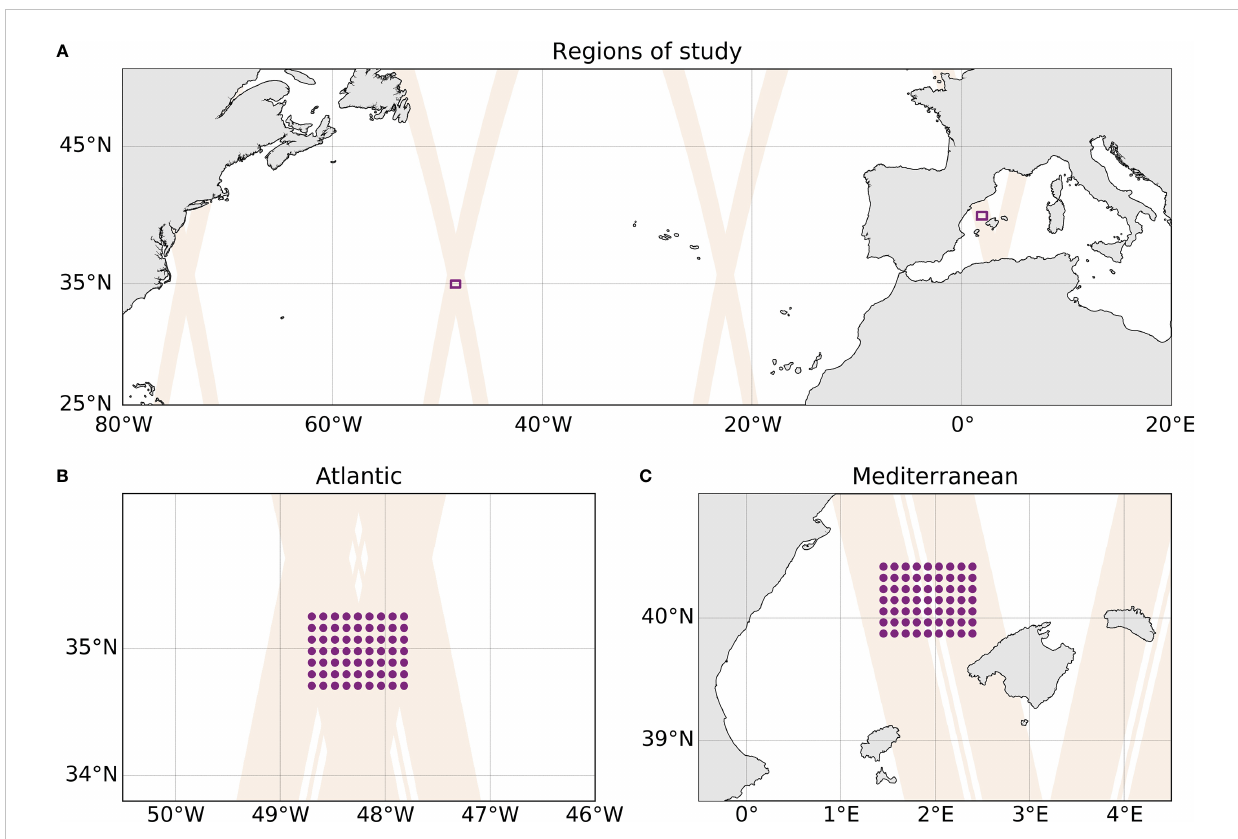
FIGURE 1 (A) Map with the regions of study (magenta boxes) and the swaths of SWOT during the fast-sampling phase (orange bands). (B, C) show a zoom around the regions of study. (B) SWOT crossover in the subpolar northwest Atlantic (orange bands) with the position of the reference con fi guration CTD casts (magenta dots). (C) Swaths of SWOT in the northwestern Mediterranean (orange bands) with the position of the reference con fi guration CTD casts (magenta dots). The coordinates of the swaths of SWOT were extracted from the simulated SWOT product from the MITgcm LLC4320 model (L2_LR_SSH), available on the AVISO website: